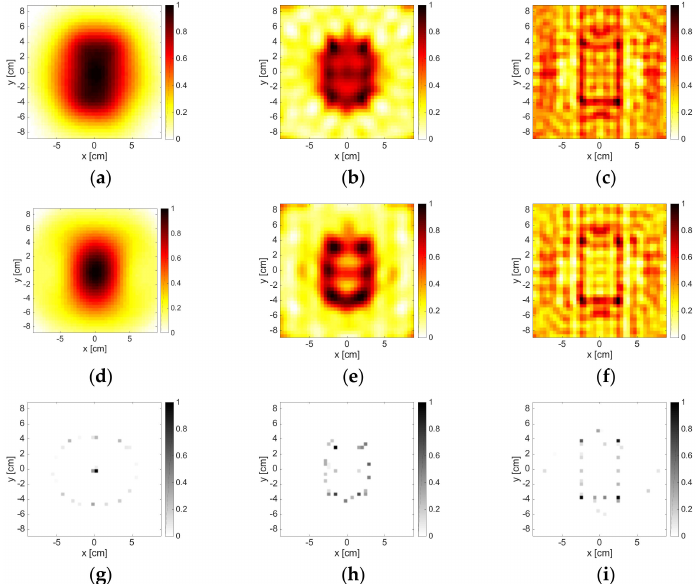
Figure 6. The U-TM-shaped target. From left to right: 2 GHz, 6 GHz, and 10 GHz. From top to bottom: LSM, OSM, and B-IS indicators. The number of measurements and views was M =